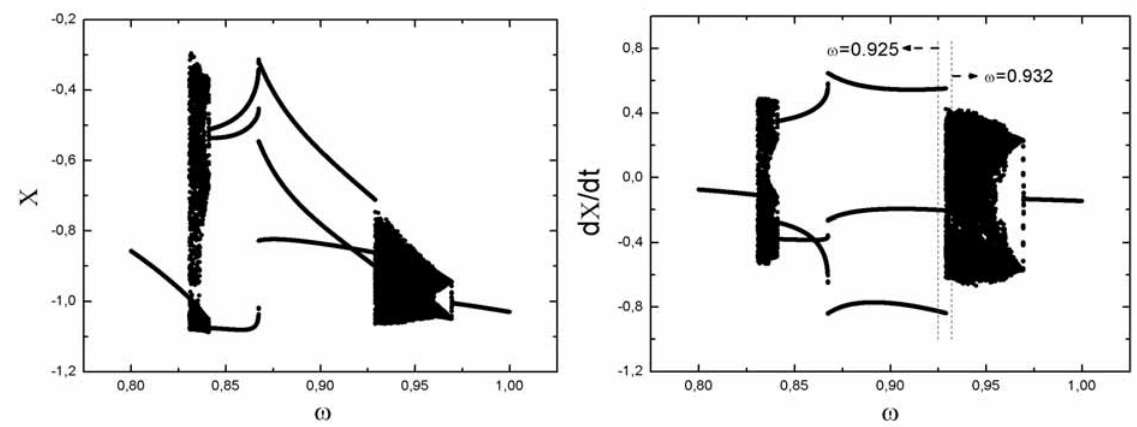
Fig. 9. Bifurcation